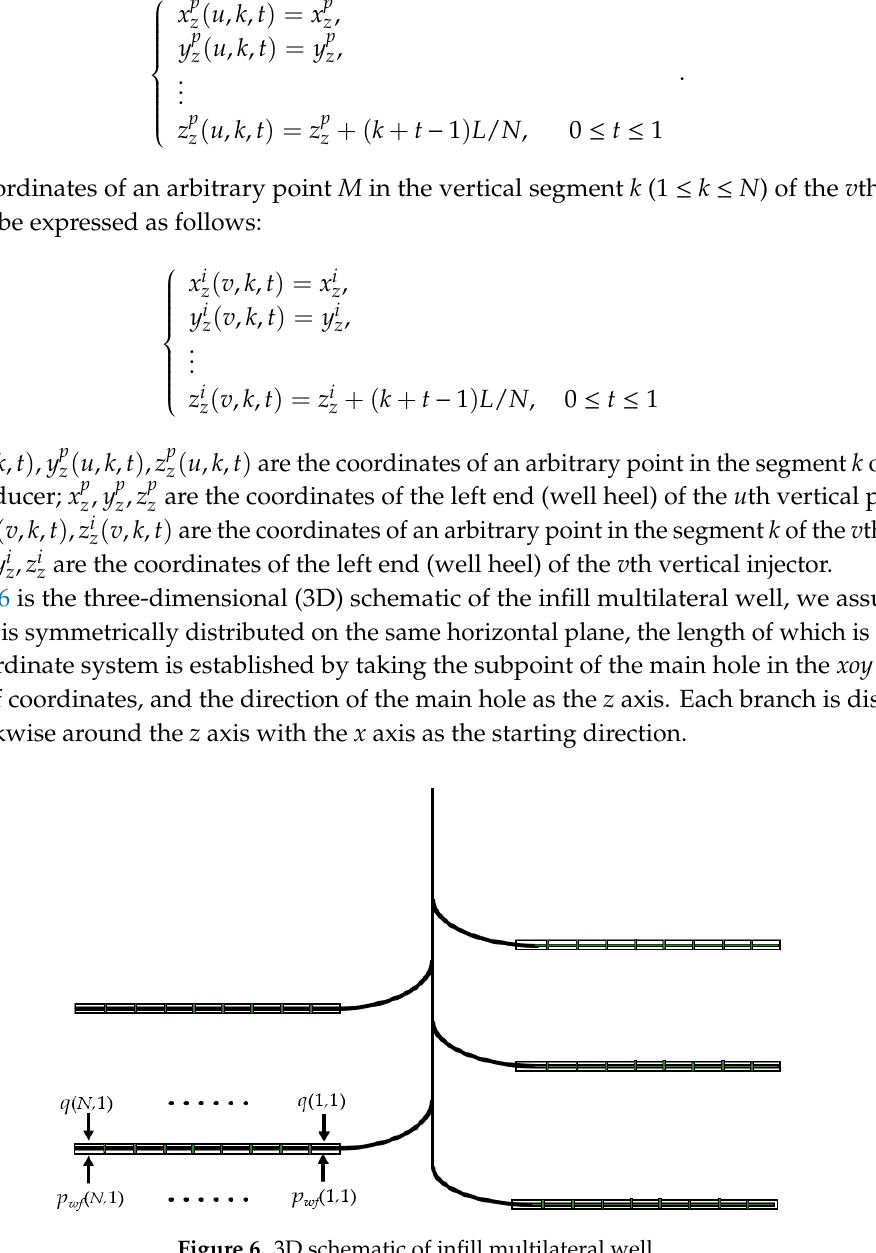
Figure 6. 3D schematic of infill multilateral well.